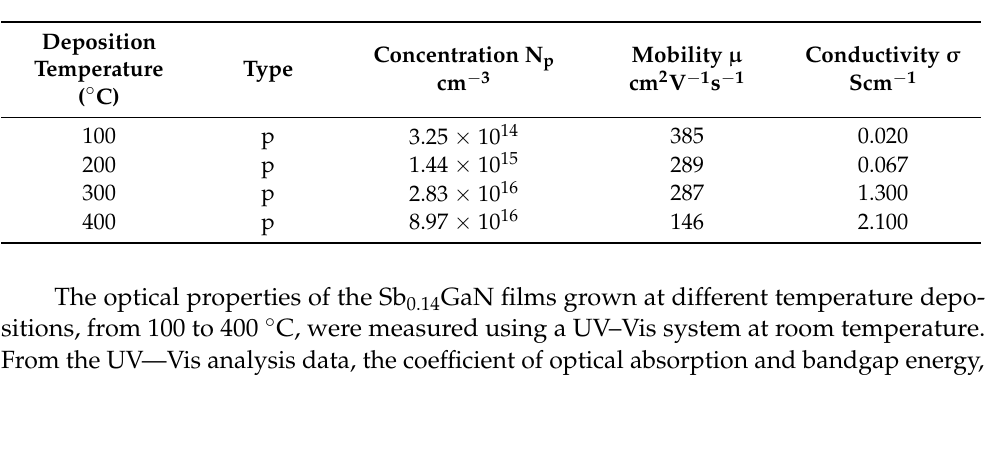
Table 4. The Electrical Properties of Sb 0.14 GaN Films Deposited at the Different Substrate Tempera-